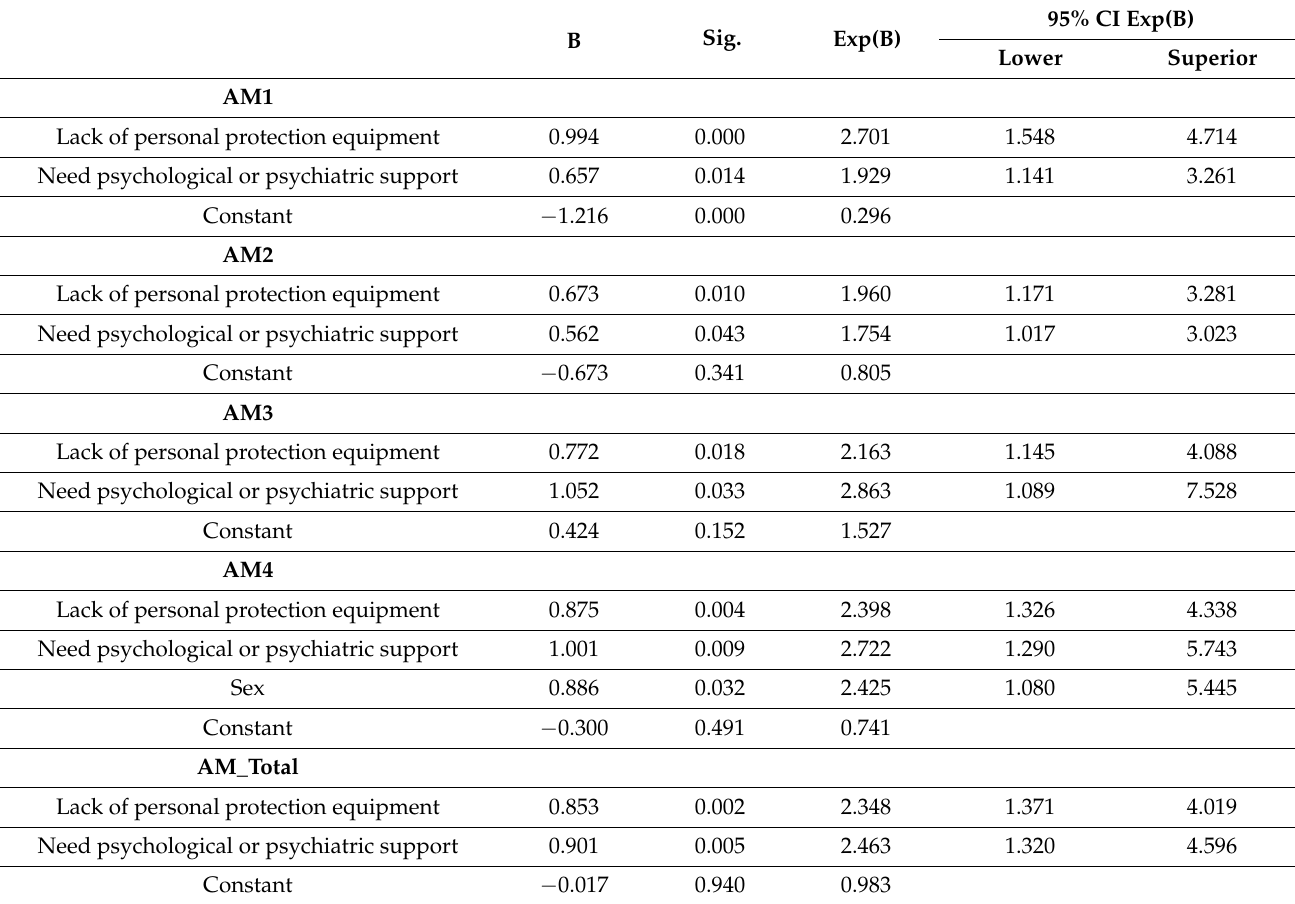
Table 4. Summary of the binary logistic regression models in MBI